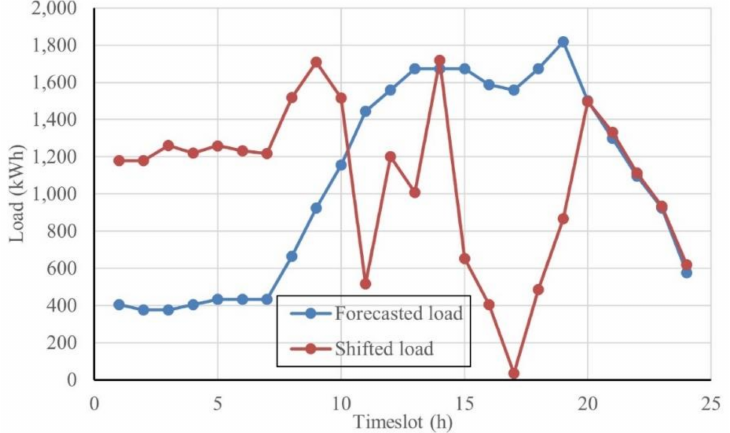
Figure 18. Hourly commercial load before and after DSM using the centralized algorithm RTP-PSO.